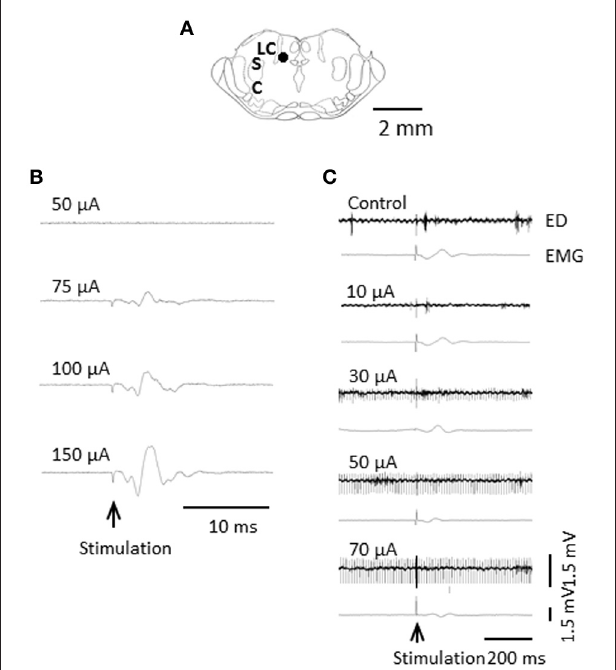
FIGURE 6 | Difference in inhibitory effect of LC/SC stimulation between the evoked discharge and the EMG activity. (A) Stimulation site of the LC/SC (closed circle). (B) The EMG activity in the masseter muscle evoked by an increase in the intensity in LC/SC stimulation. (C) An example of the effect of graded LC/SC stimulation on the evoked discharge and the EMG activity. Note that LC/SC stimulation at a stimulus intensity below 50 μ A never produced EMG activity of the masseter muscle associated with stimulation of the mesencephalic trigeminal nucleus, located just lateral to the LC/SC, and that EMG activity was still observed even when the evoked discharge was completely inhibited by LC/SC stimulation at an intensity over 50 μ A. Electrical stimulation of the descending colon is indicated by the arrow. (Tsuruoka et al.,